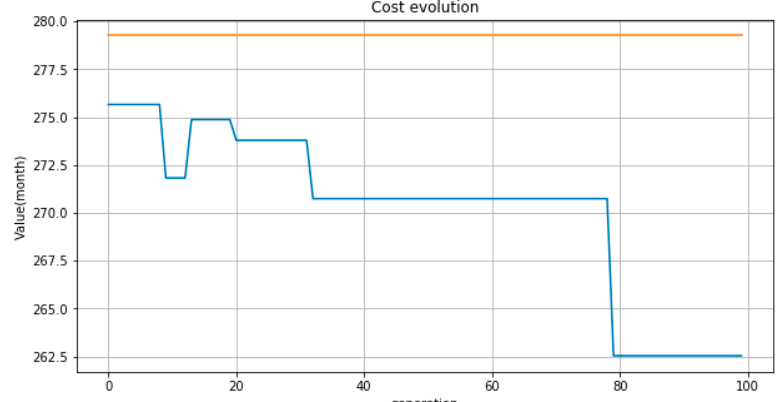
Figure 8. The evolution of the cost during the running of the algorithm: in orange color, the cost for an unplanned scheme, and in blue color, the cost for the best individual of the generation (in the figure the evolution is stopped at 100 generations).